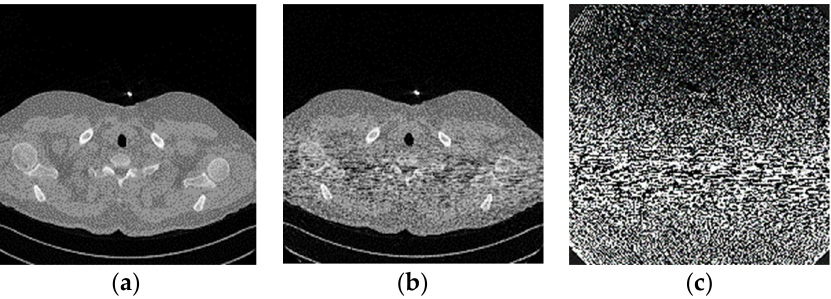
Figure 11. ( a ) Full dose scan image, ( b ) synthetic low-dose image at PSNR 50.7883 dB, and ( c ) noise